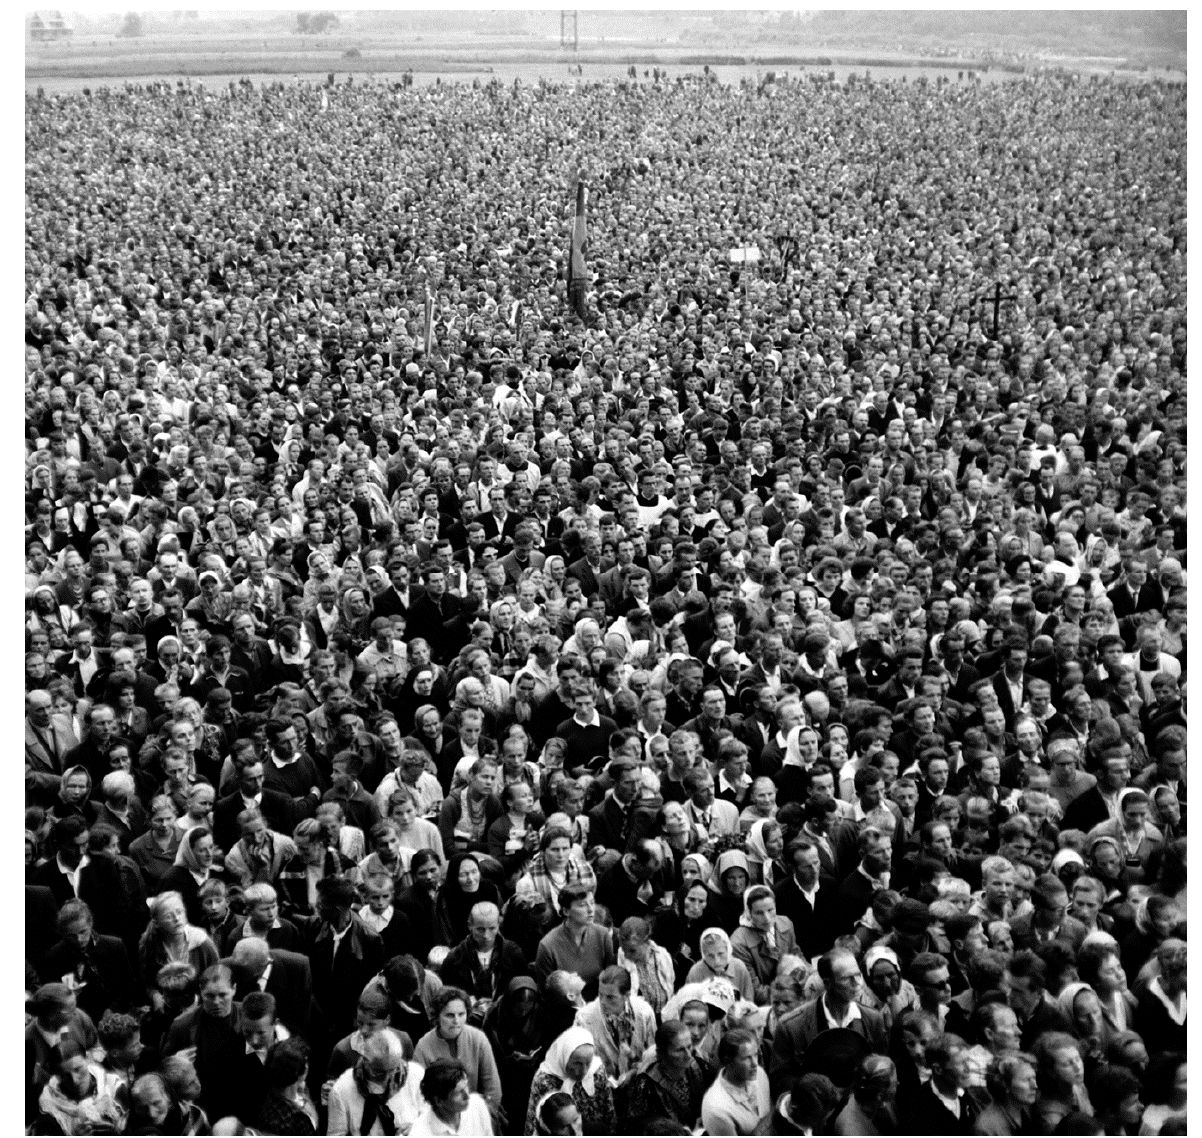
Figure 10. Celebrations of the coronation of the statue of Our Lady of Lud ź mierz—Queen of Podhale in Lud ź mierz (15 August 1963) (photo: Archives of the Shrine of Our Lady of Lud ź mierz—Queen of Podhale in Lud ź mierz).